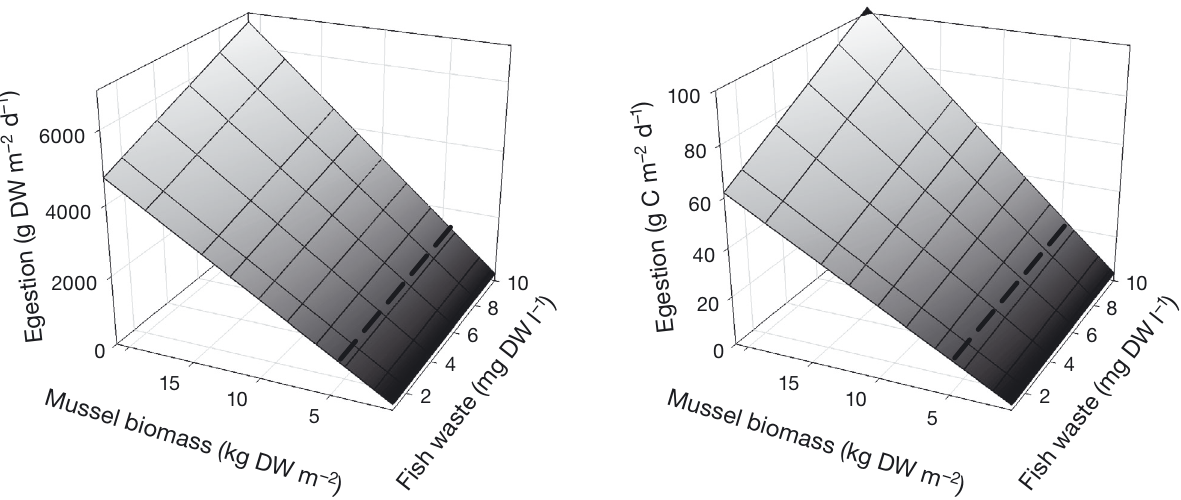
Fig. 4. Estimated total dry weight (DW; left plot) and carbon (right) egestion rates for ranges of depth-integrated mussel stock- ing biomass (tissue DW) and suspended fish waste concentrations. The dashed lines show results for typical mussel densities at commercial Integrated Multi-Trophic Aquaculture farms in the Bay of Fundy, Canada. Calculation details are provided under ‘Biomitigation potential’ in the main